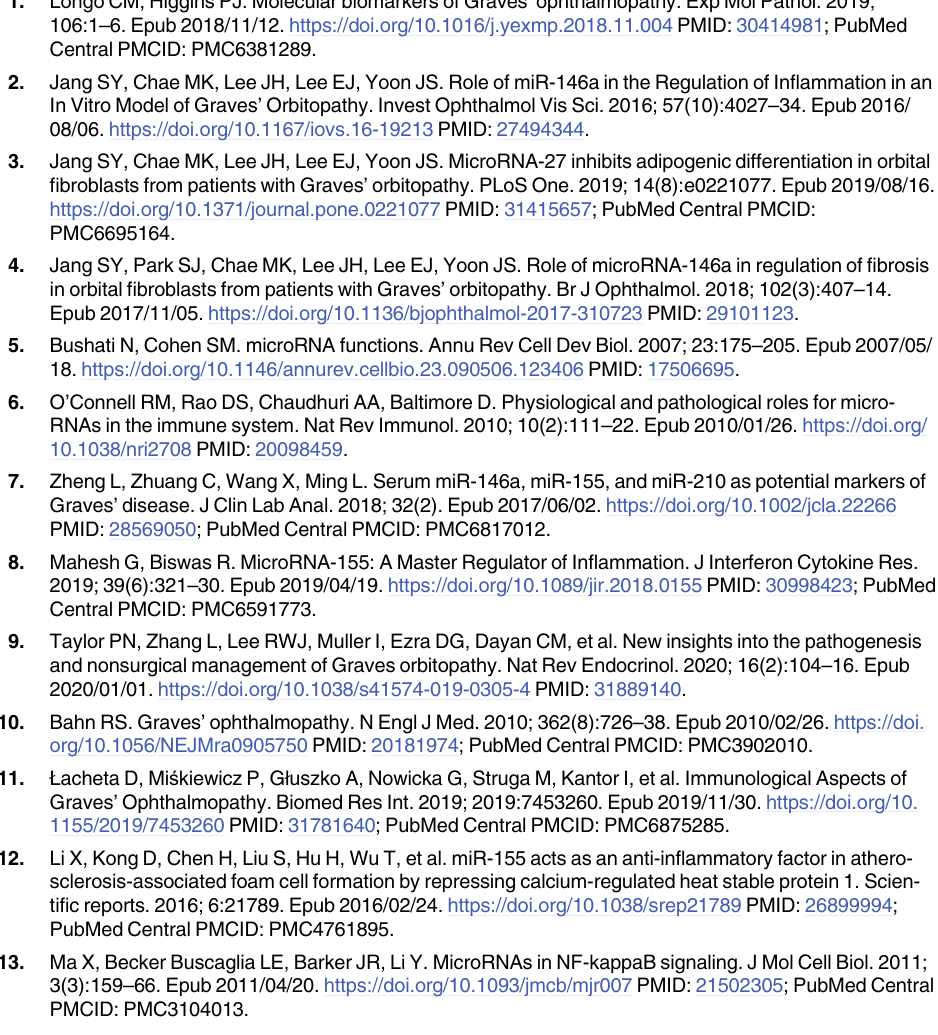
S2 Fig. Full-length gels of representative Western blots for Figs 3 and